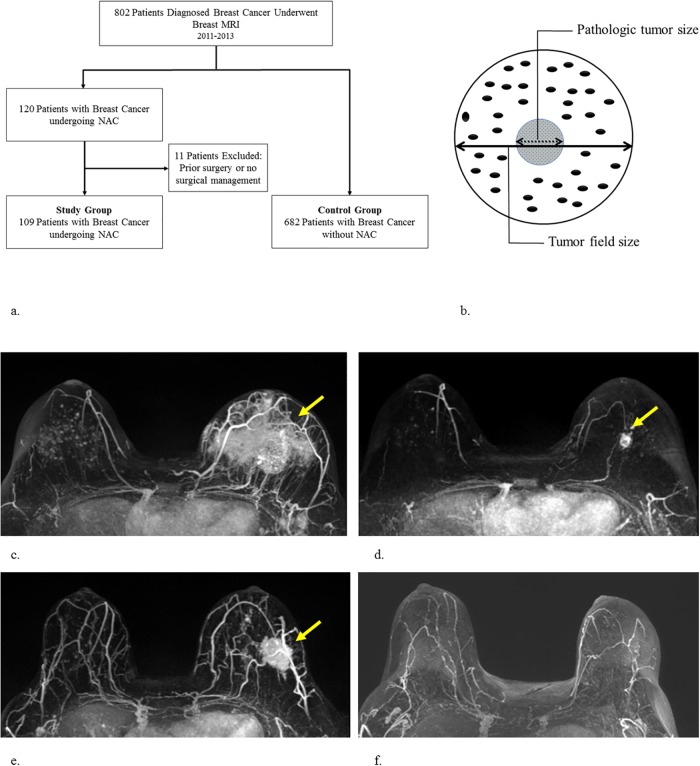
Study design, illustration of tumor size, and MRI interpretation.(a) Study design. (b) The definitions of tumor field size and pathologic tumor size. (c,d) Luminal type A cancer of left breast. Baseline MRI scan before (c) and after (d) NAC treatment. After NAC treatment, the mass had decreased in size to 2.2cm. Response was classified as non-complete response. The final pathologic analysis disclosed a measurement of 1.3cm. Therefore, MRI overestimated the tumor size of the residual tumor. (e,f) Triple negative tumor of left breast. Baseline MRI scan before (e) and after the NAC treatment was completed (f). Following NAC, pCR was suggested by both MRI and final pathology. The tumor sizes of breast MRI and pathology are concordant.